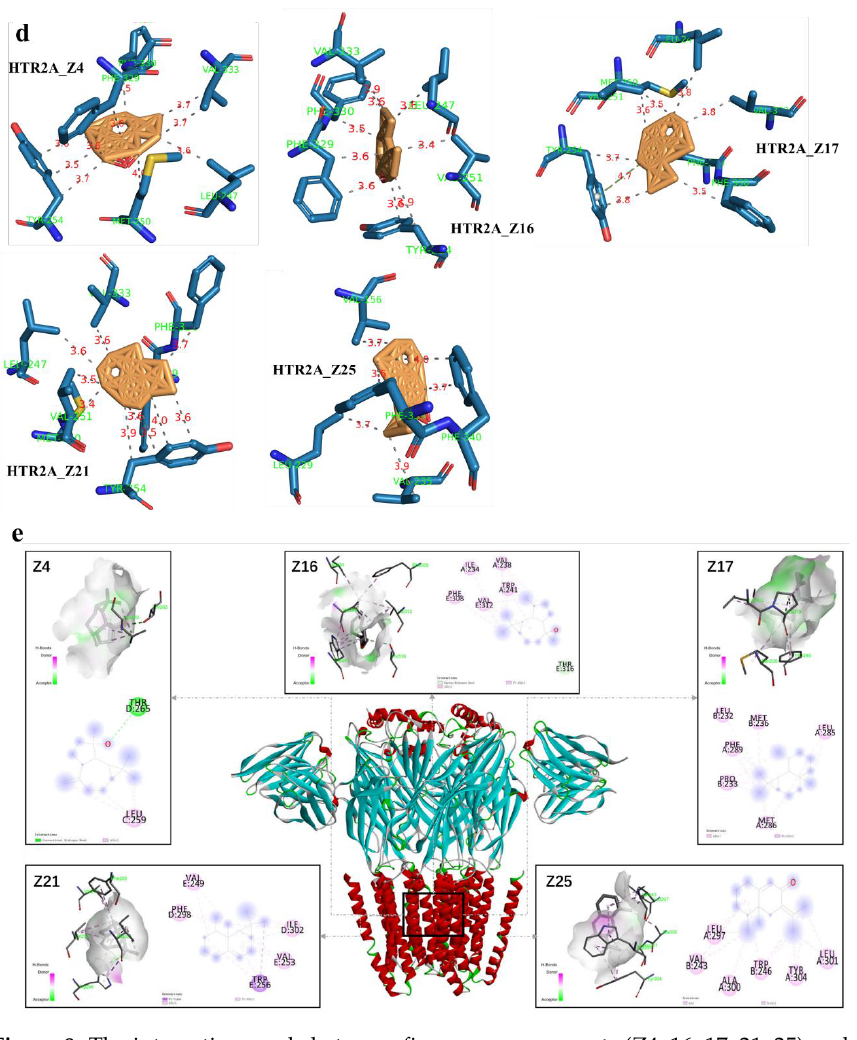
Figure 8. The interaction mode between five core components (Z4, 16, 17, 21, 25) and four targets. ( a ) GABRA1; ( b ) GRIA1; ( c ) HTR1A; ( d ) HTR2A; ( e ) 3D picture.